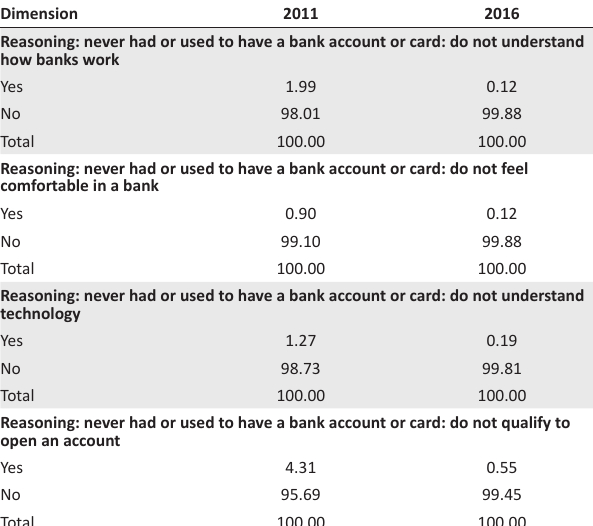
TABLE 3-A1: Description of data on the quality dimension of financial inclusion ( % ). Dimension 2011 2016